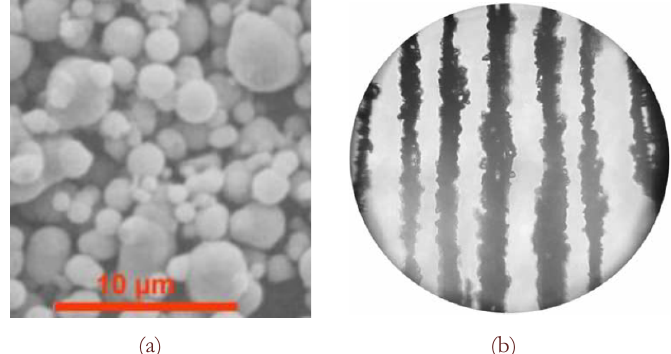
Figure 1: Microfotography of a MR fluid with no magnetic field, where particles are randomly dispersed (a). Microphotography MR fluid with an applied magnetic field with parallel chains of carbonyl iron